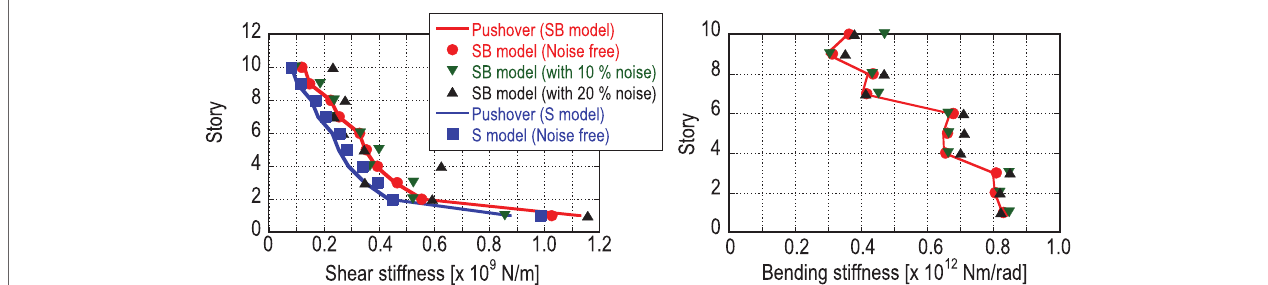
FIGURE 8 | Identified shear stiffness and bending stiffness in simultaneous measurement.